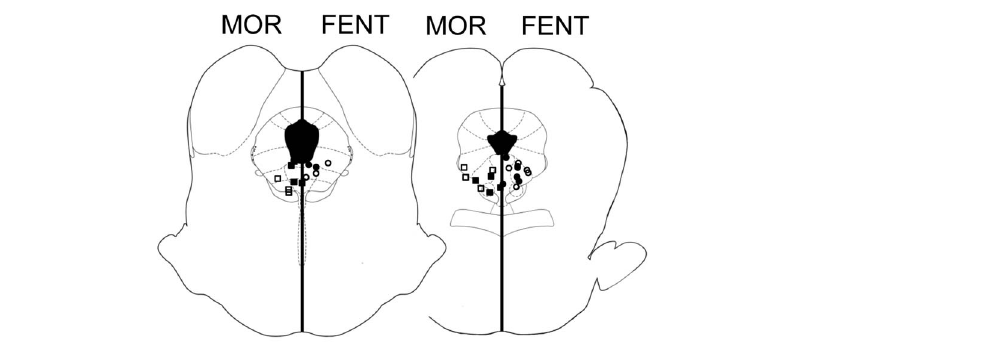
Fig. 2. Location of representative microinjection sites in the ventrolateral PAG. Morphine injections (filled squares) are shown on the left and fentanyl injections (filled circles) on the right even though all injections were administered on the right side of the PAG. The effect of the opioid was compared between rats receiving repeated opioid (closed symbols) and saline injections (open symbols). All injections were located between coronal sections 0.98 and 1.56 from the interaural line